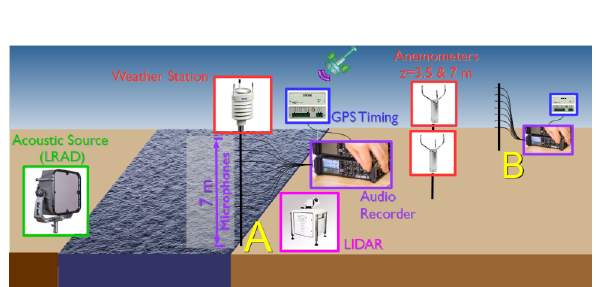
Figure 3: Schematic of measurement system components in a sample